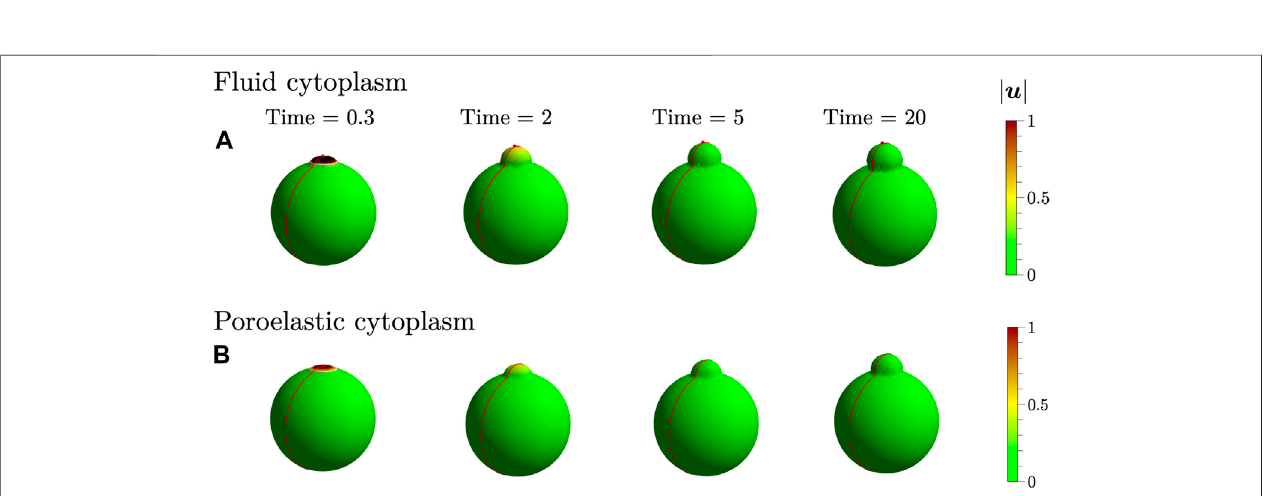
FIGURE 2 | A bleb is initiated by either (A) loss of membrane-cortex adhesion or (B) cortical ablation. (C) Top down view of the cell. For (A) , membrane-cortex adhesionparametersaresettozerowithintheblebringregion,whereasfor (B) corticalstiffnessandcortex-cytoskeletonadhesionparametersarealsosettozerowithin the bleb region (inside the dashed-line circle). The two red points are used to compute the relative change in bleb ring diameter. The blue circle shows the point with the largest z -coordinate on the cell that is used to compute bleb height.